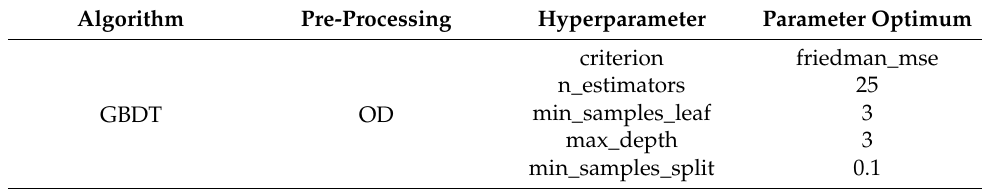
Table 3. Information on the GBDT model for groundwater TPH contamination